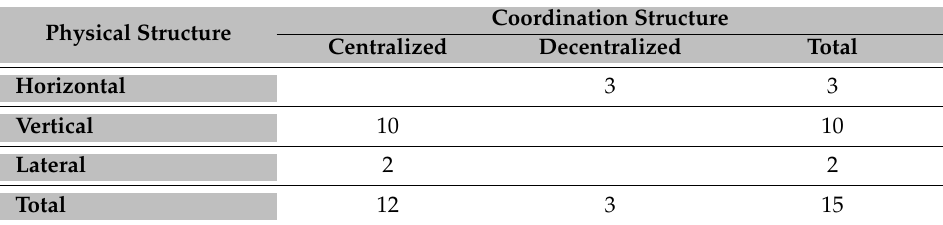
Table 2. Cases studies of freight industry collaboration in